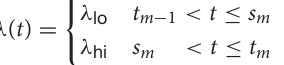
total lengths of time within the study period [0, T ] (see Figure 4 ) that the PDC frequency is at its high and low levels,